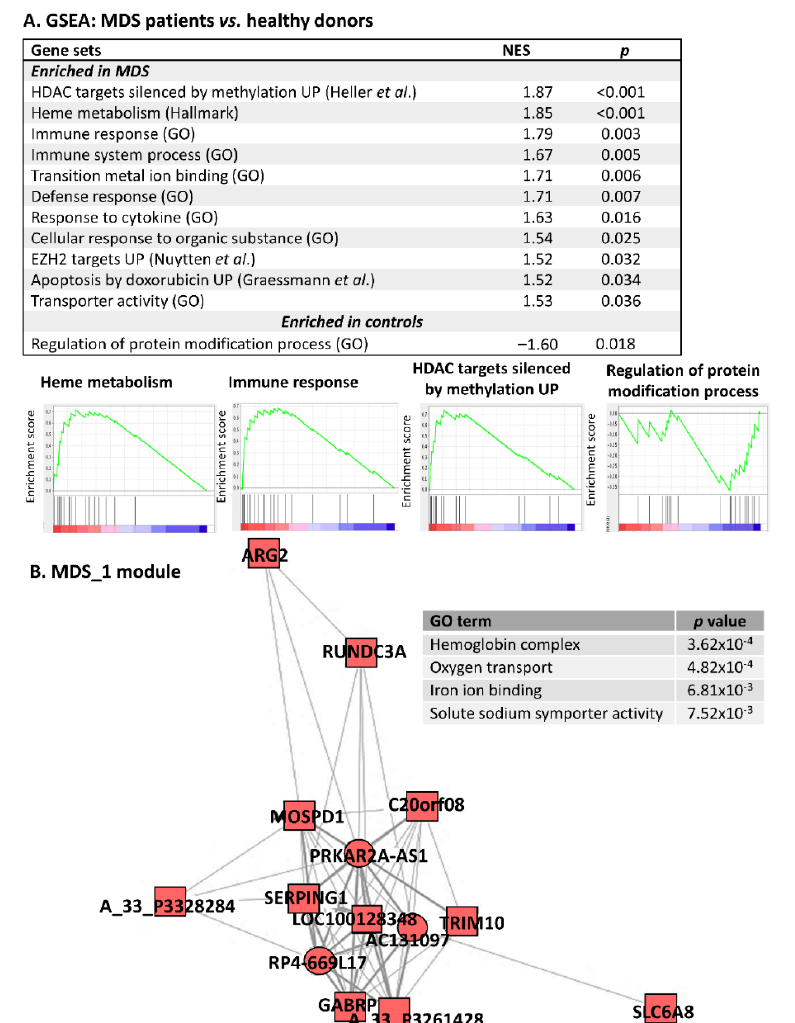
Figure 1. Pathway analysis of genes deregulated between MDS patients and healthy donors. ( A ) Gene set enrichment analysis (GSEA) of differentially expressed PCGs and four enrichment plots for selected enriched gene sets. NES - normalized enrichment score. References: Heller et al. [9], Nuytten et al. [10], and Graesmann et al. [11]. ( B ) MDS_1 module from the lncRNA-PCG coexpression network. The Gene Ontology (GO) terms significantly associated with these modules are listed in the corresponding table. Square-PCG, circle-lncRNA, red-upregulated in MDS.